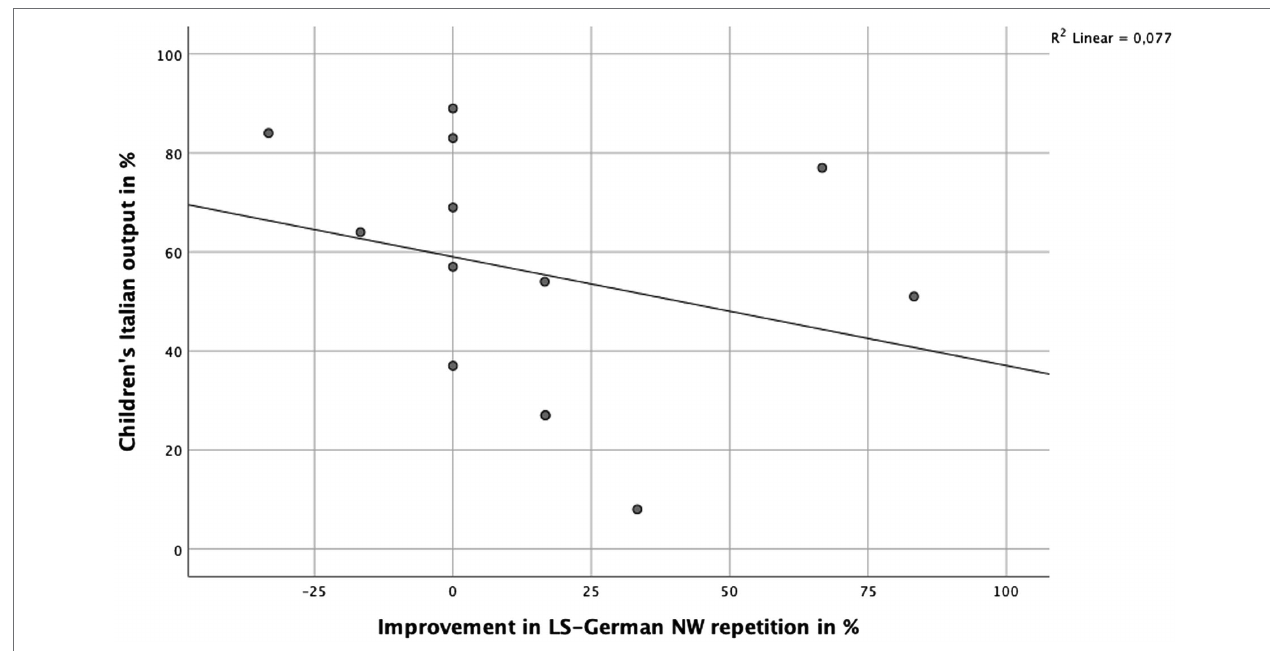
FIGURE 5 | Children’s improvement of correctly repeated LS German NWs from T1 to T2 ( x -axis) according to their Italian output ( y -axis). n = 13. Note: Two data points overlap (Italian output 27%, LS-German NW repetition improvement